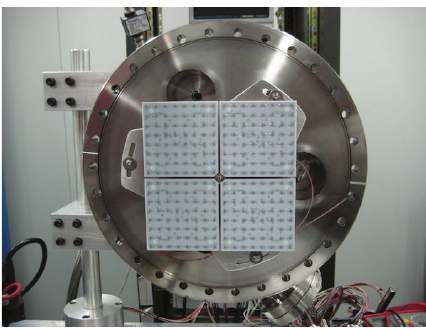
Figure 26: Dice boards installed in NEXT-DEMO, containing 64 (8 × 8) MPPCs each. There will be about 100 such boards in NEXT-